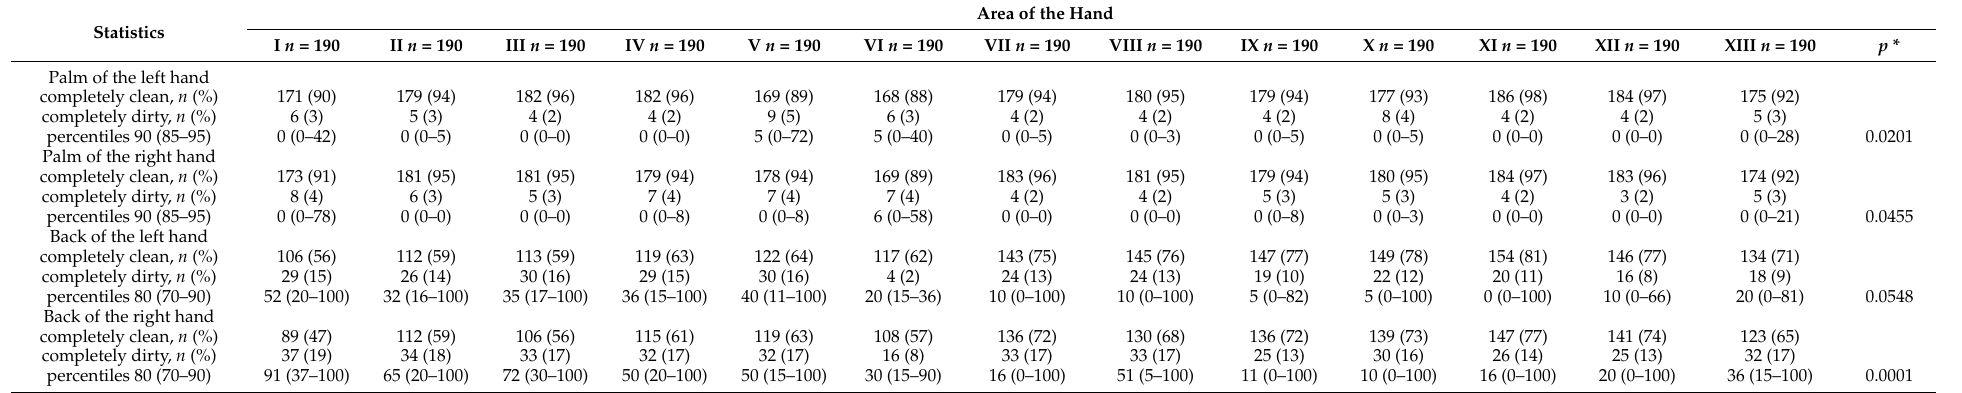
Table 1. Descriptive statistics of the frequency with which the examined thirteen areas of the four hand surfaces are missed by